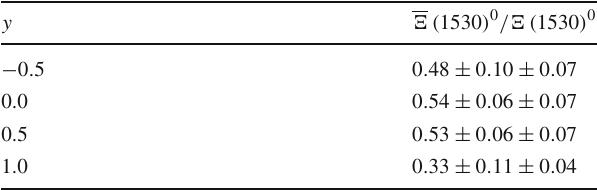
Table 6 Ratio of p T integrated yields versus rapidity of (cid:2)( 1530 ) 0 and (cid:2)( 1530 ) 0 produced in inelastic p+p interactions at 158 GeV / c beam momentum. Rapidity values correspond to the middle of the presented bin. The first value is the particle multiplicity, the second represents the statistical uncertainty, and the third corresponds to the estimated systematic uncertainty y (cid:2)( 1530 ) 0 /(cid:2)( 1530 )